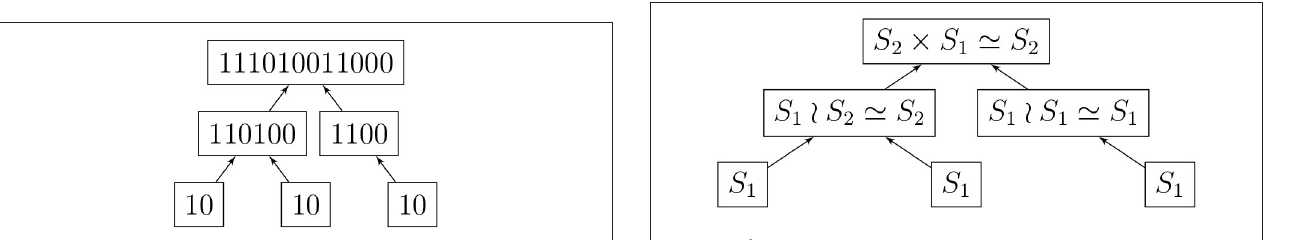
FIGURE 2 | How to code a rooted tree.